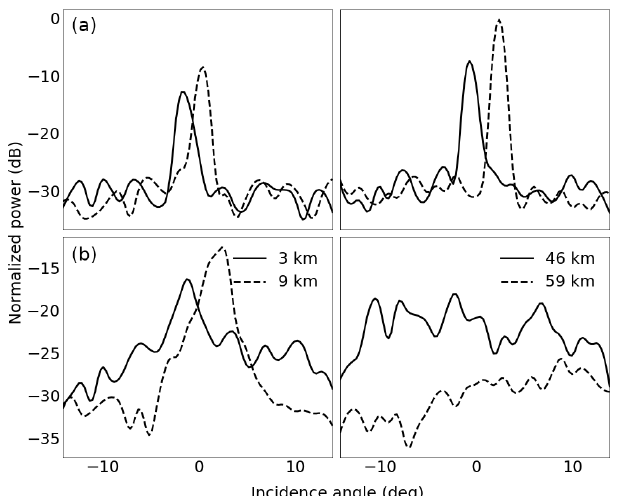
Figure 6. Internal layer (a) and bed (b) returns for track 2 at azimuth positions x = ( 3 , 25 , 32 , 54 ) km, marked with vertical red lines in Fig. 4a. Quadratic interpolation was applied to smooth the signa-